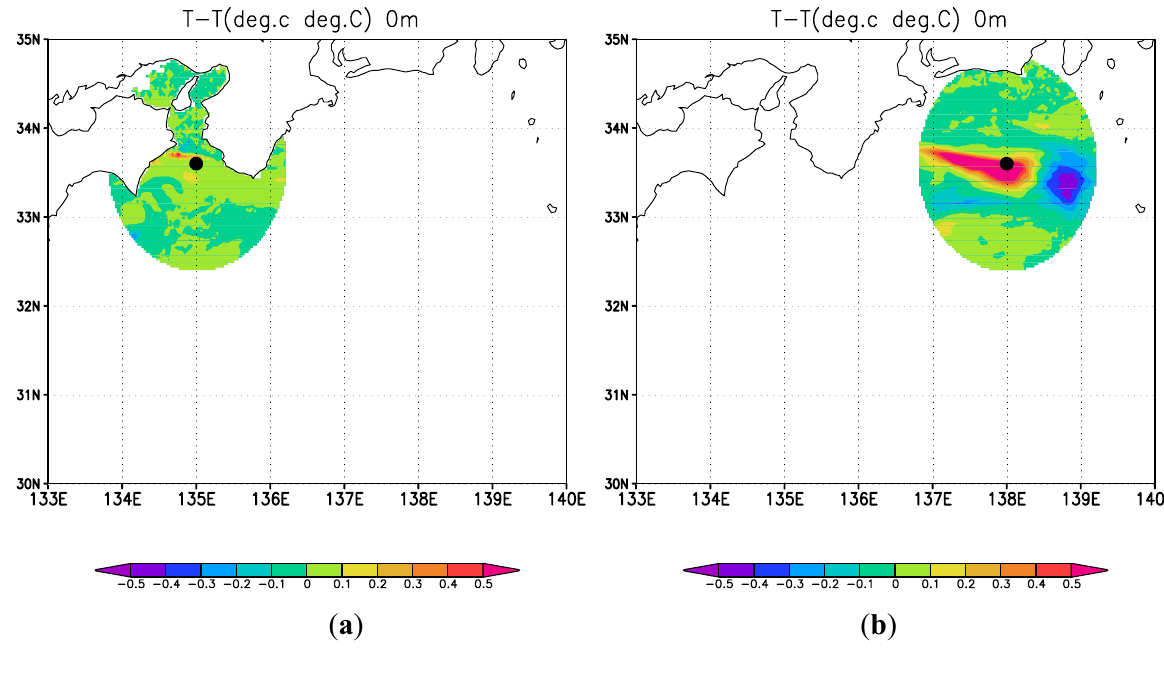
Figure 8. The forecast error covariance between SST at a target point and SST at surrounding grids on 20 February 2010. Values on the grids with distance from the target point larger than a localized scale ( ° 2.1~2 310 dist σ= ; [10]) are not shown. obszero